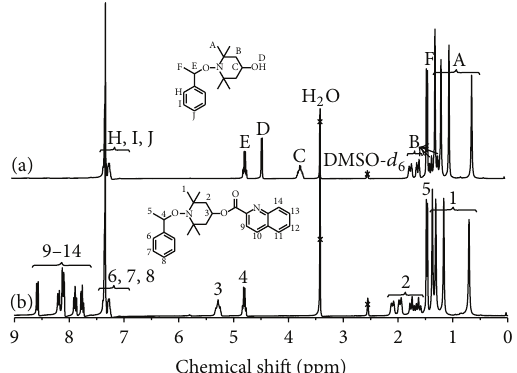
Figure 1: 1 H NMR spectra of (a) PS-TEMPO-OH and (b) PS- TEMPO-Q.